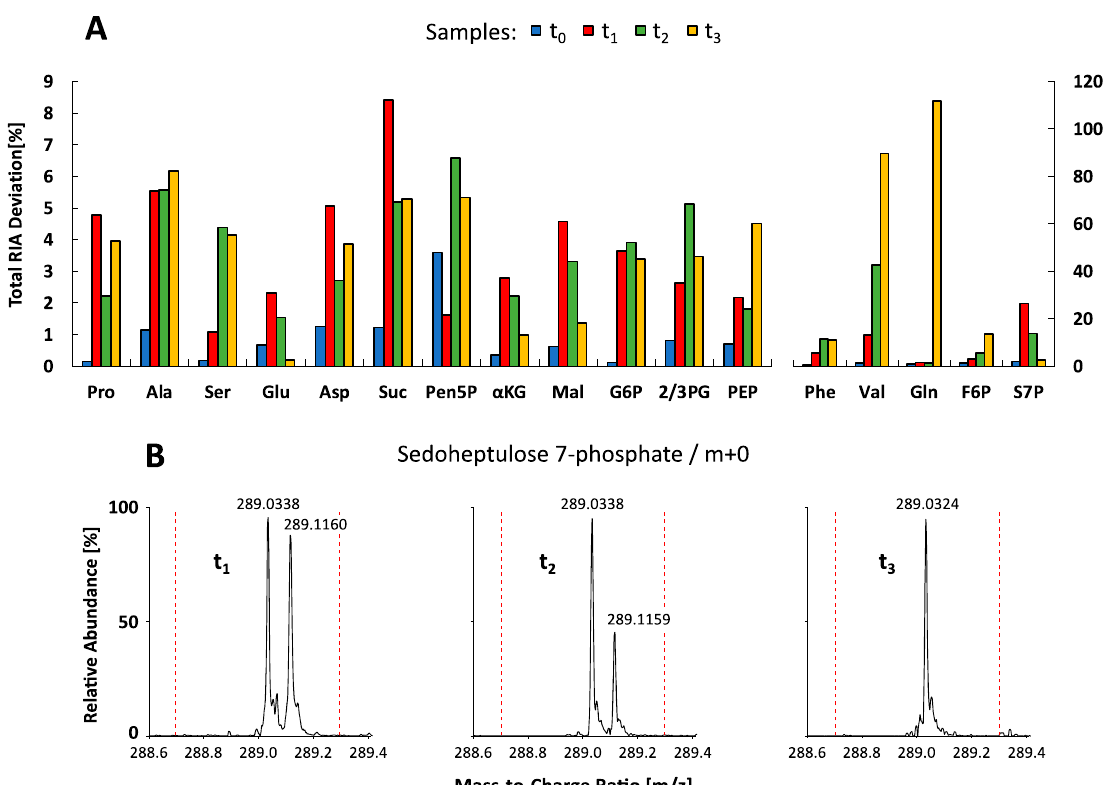
Figure 6. Conformity analysis of relative isotopologue abundances (RIA). ( A ) Total RIA deviations between the QTOF-HRMS and QQQ-SIM 13 C-labeled datasets (t 0 < 0 s, t 1 = 28 s, t 2 = 52 s, t 3 = 10 h) are shown as bar plots for all metabolites. See Tables S1–S4 for the full names of abbreviated metabolites. ( B ) High-resolution QTOF mass spectra (t R = 22.4 min) of 13 C-labeled C. glutamicum metabolite extracts (t 1 –t 3 ) showing the monoisotopic ion cluster of sedoheptulose 7-phosphate ( m/z 289.0338 and m/z 289.0324) and an adjacent ion cluster identified as argininosuccinic acid ( m/z 289.1160 and m/z 289.1159). Dashed red lines indicate the mass resolution of the QQQ-SIM system ( m/z 0.3).